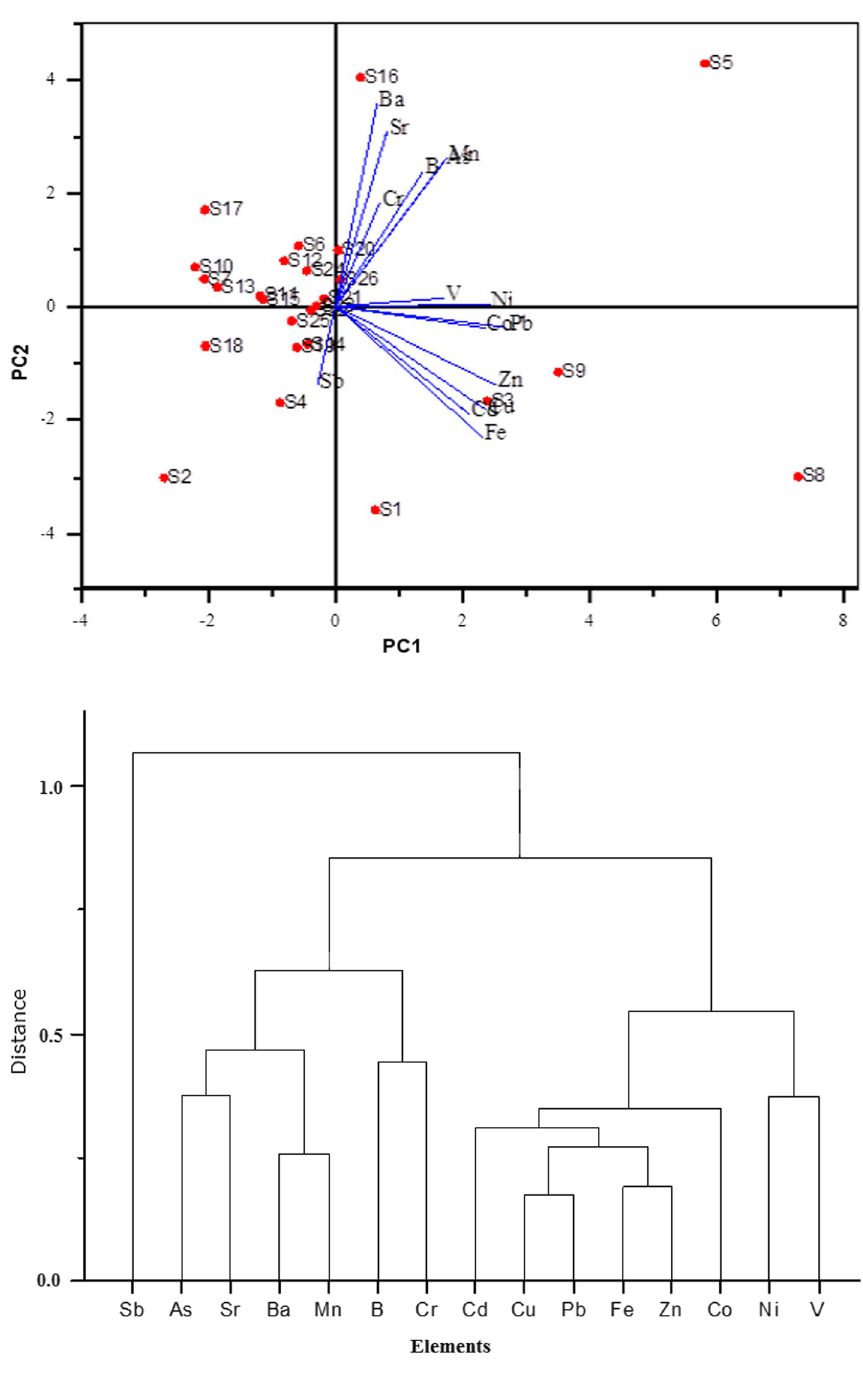
Fig. 2 Biplot of scores and loadings matrices for the first two PCs of river water samples